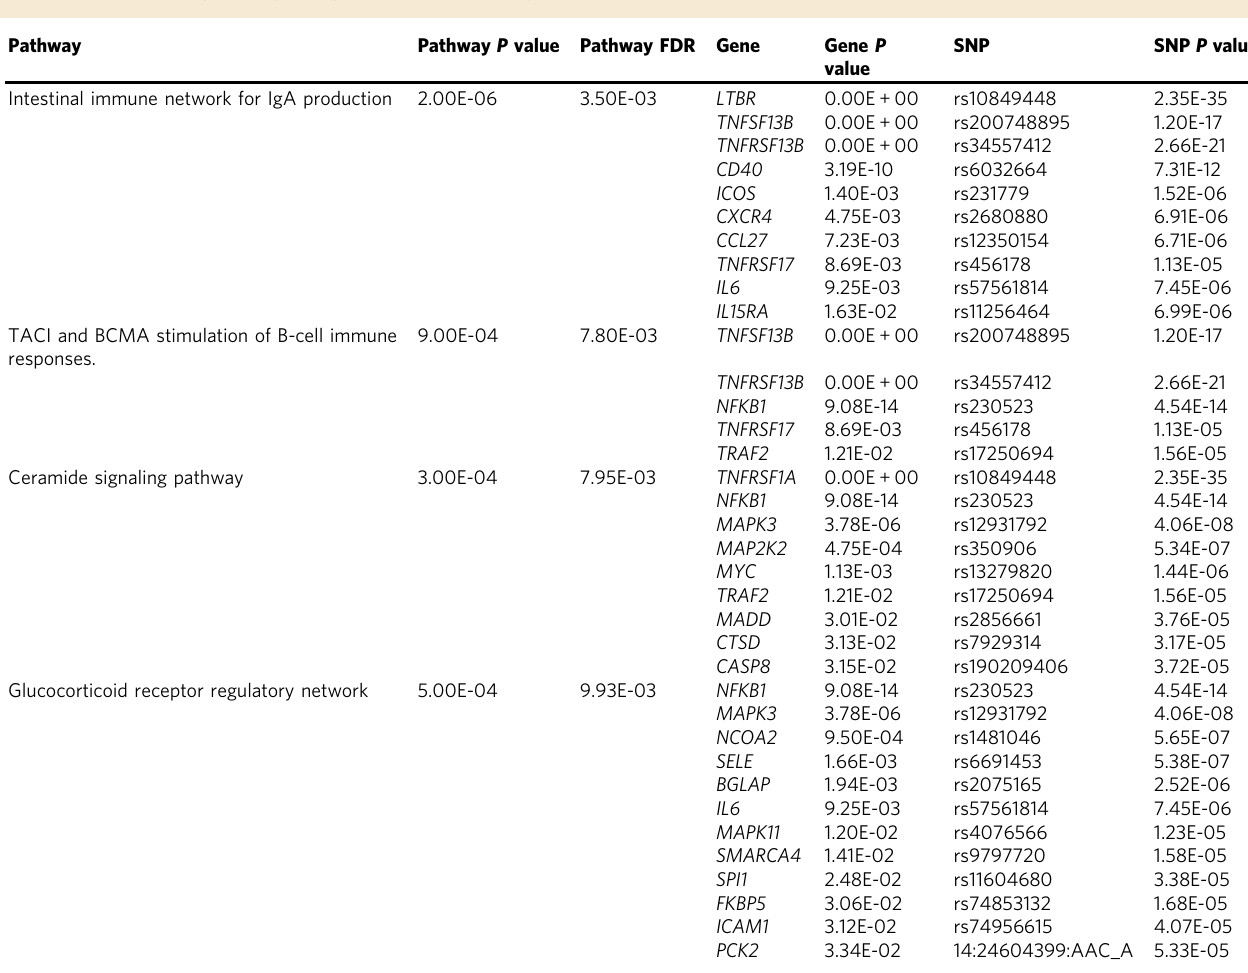
Table 7 MAGENTA pathway analysis on tonsillectomy GWAS Pathway Intestinal immune network for IgA